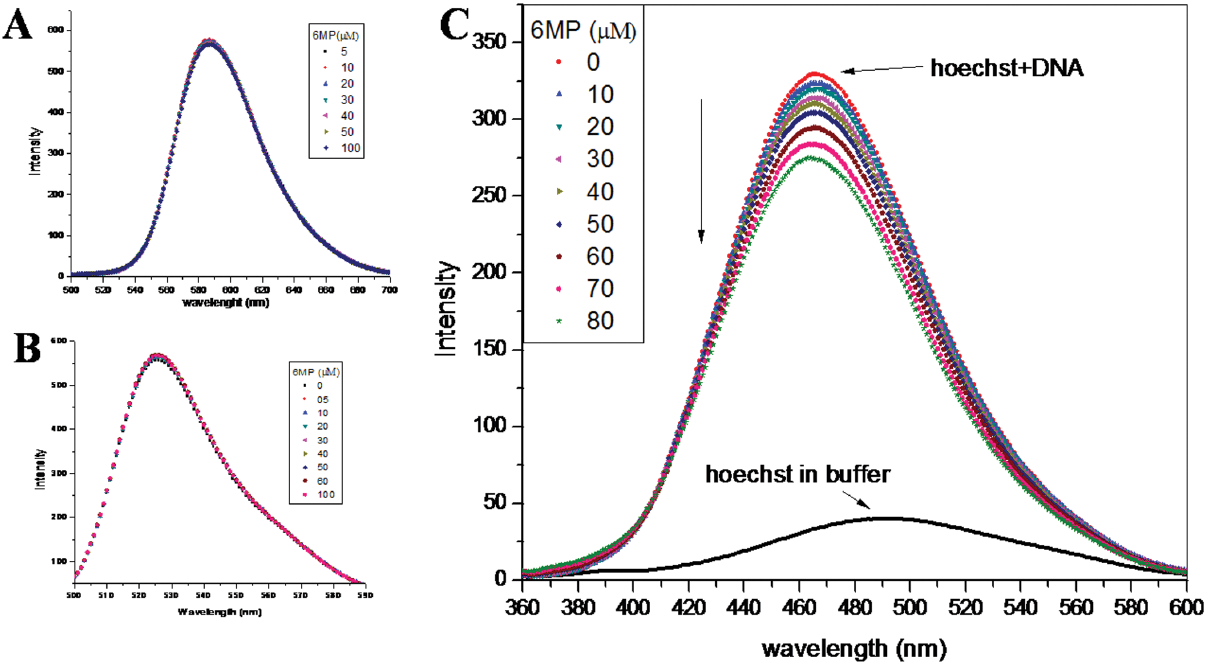
Figure 4. Competitive displacement assays. ( A ) Fluorescence titration of CT-DNA and EB (intercalator) complex with 6MP. EB-DNA complex was excited at 471 nm and emission spectra were recorded from 500–700 nm. No change in fluorescence intensity was recorded with addition of increasing concentration of 6MP ( B ) Fluorescence titration of CT-DNA and AO (intercalator) complex with 6MP. CT-DNA-AO complex was excited at 471 nm and emission spectra were recorded from 500–600 nm. No change in fluorescence intensity was recorded with addition of increasing concentration of 6MP. ( C ) Fluorescence titration of CT- DNA and Hoechst (groove binder) complex with 6MP. Fluorescence intensity decreases with subsequent addition of 6MP. CT-DNA-Hoechst complex was excited at 343 nm and emission spectra were recorded from 360–600 nm.